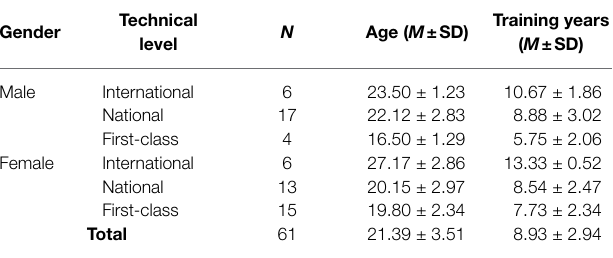
TABLE 1 | Participants’